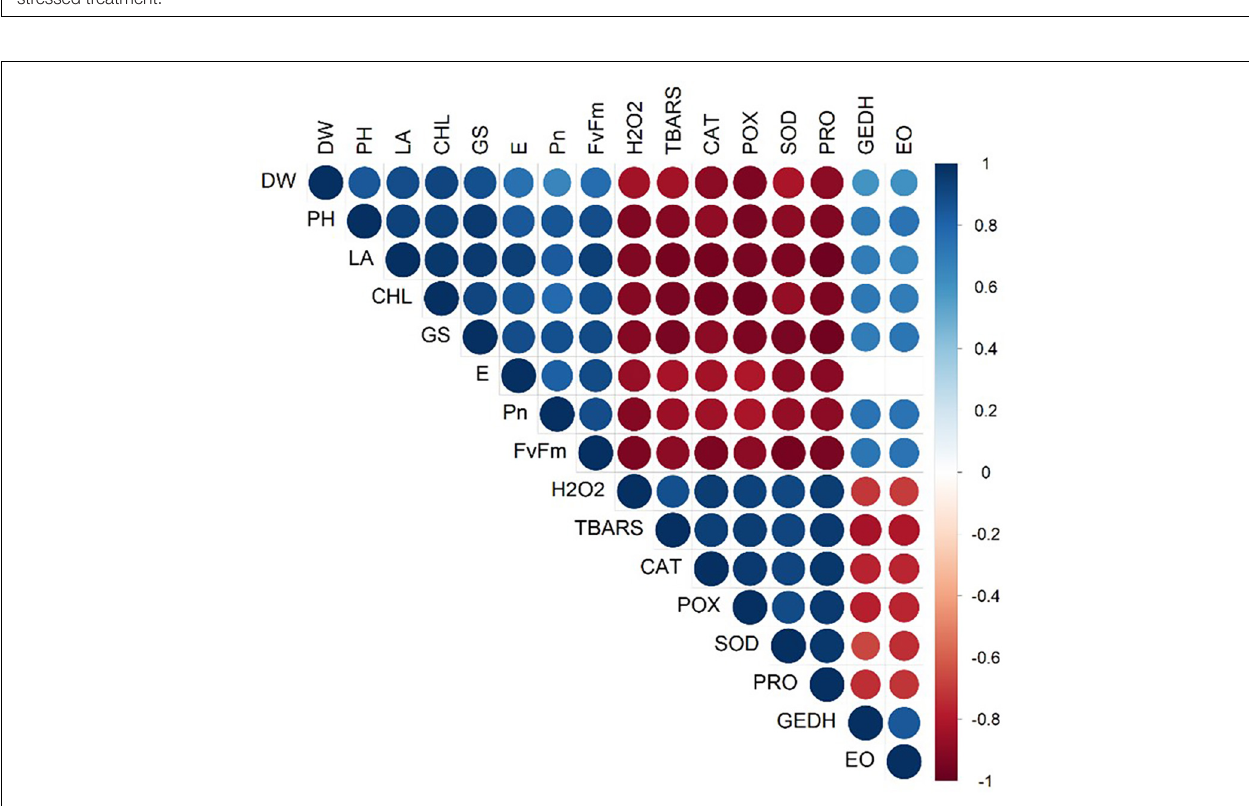
FIGURE 9 | Pearson correlation index heatmap of all tested parameters under different saline regimes (0, 40, 80, 160, and 240 mM of NaCl). The positive correlation is shown with blue colour while the red colour represents a negative correlation. Non-significant correlations at α = 0.05 are excluded from the heatmap. DW, dry weight; PH, plant height; LA, leaf area; CHL, chlorophyll content; GS, stomatal conductance; E, transpiration rate; Pn, net photosynthetic rate; Fv/Fm, quantum yield; H 2 O 2 , hydrogen peroxide content; TBARS, thiobarbituric acid reactive substances content; CAT, catalase activity; POX, peroxidase activity; SOD, superoxide dismutase activity; PRO, proline content; GEDH, geraniol dehydrogenase activity; EO, essential oil content.